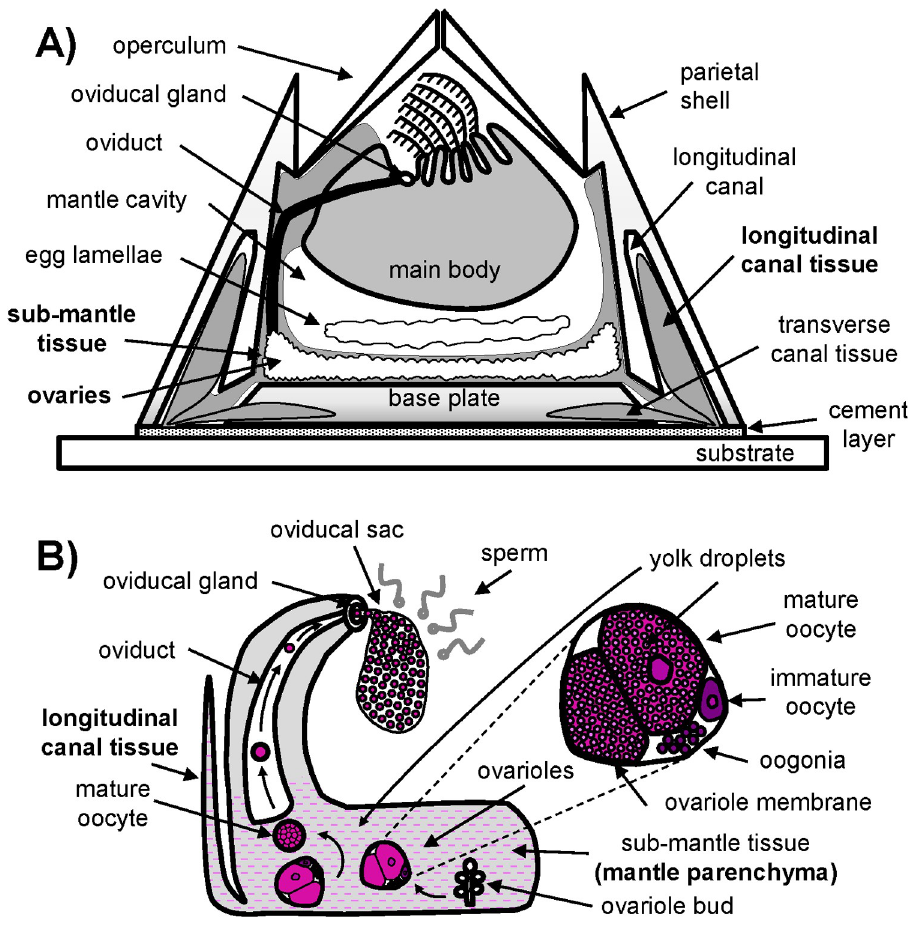
Fig 1. Generalized schematic of acorn barnacle and female reproductive tissue. A) Sagittal schematic highlighting the main body, the main components and showing the location of the LCT, and the sub-mantle region. B) Schematic identifying different structures of the female reproductive system and its relation to